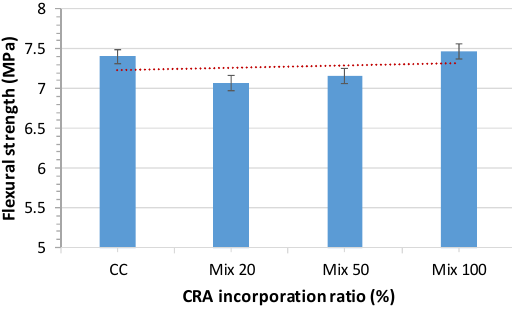
Figure 17. 28-day flexural strength test results.